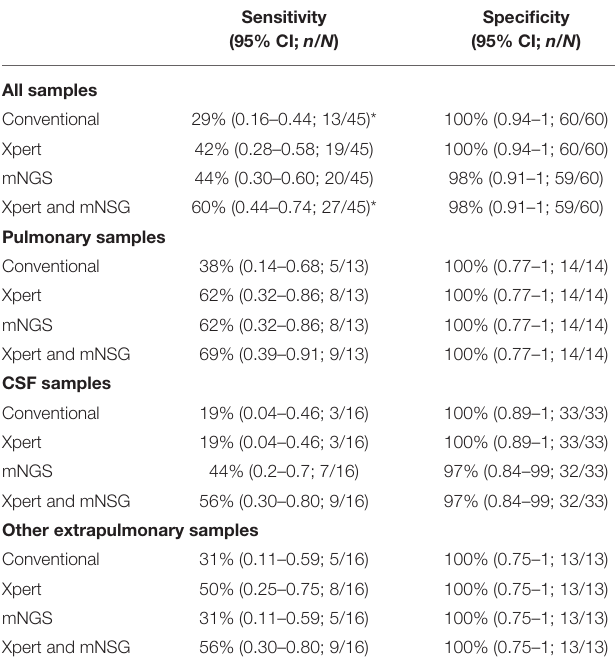
TABLE 2 | Diagnostic performance of MTB for mNGS, Xpert, and traditional methods compared with the clinical final diagnosis.